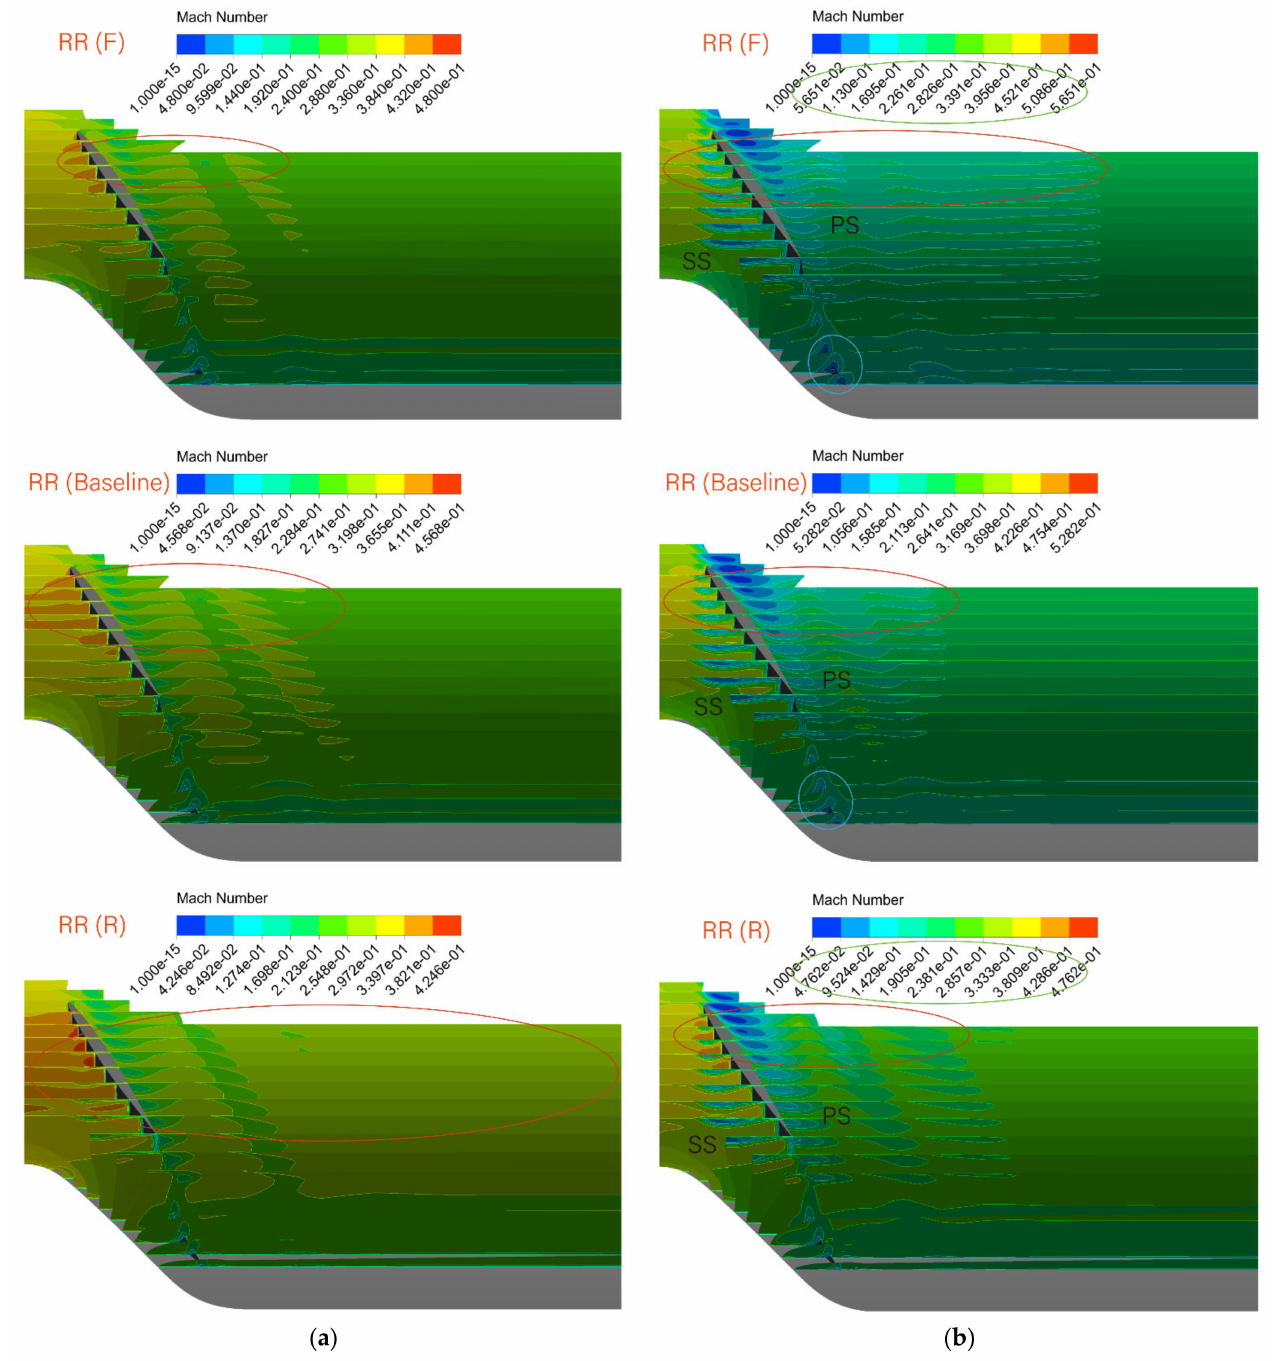
Figure 15. ( a ) Comparison of the RRs based on the Mach number contour at the design points; ( b ) comparison of the RRs based on the Mach number contour near the stall